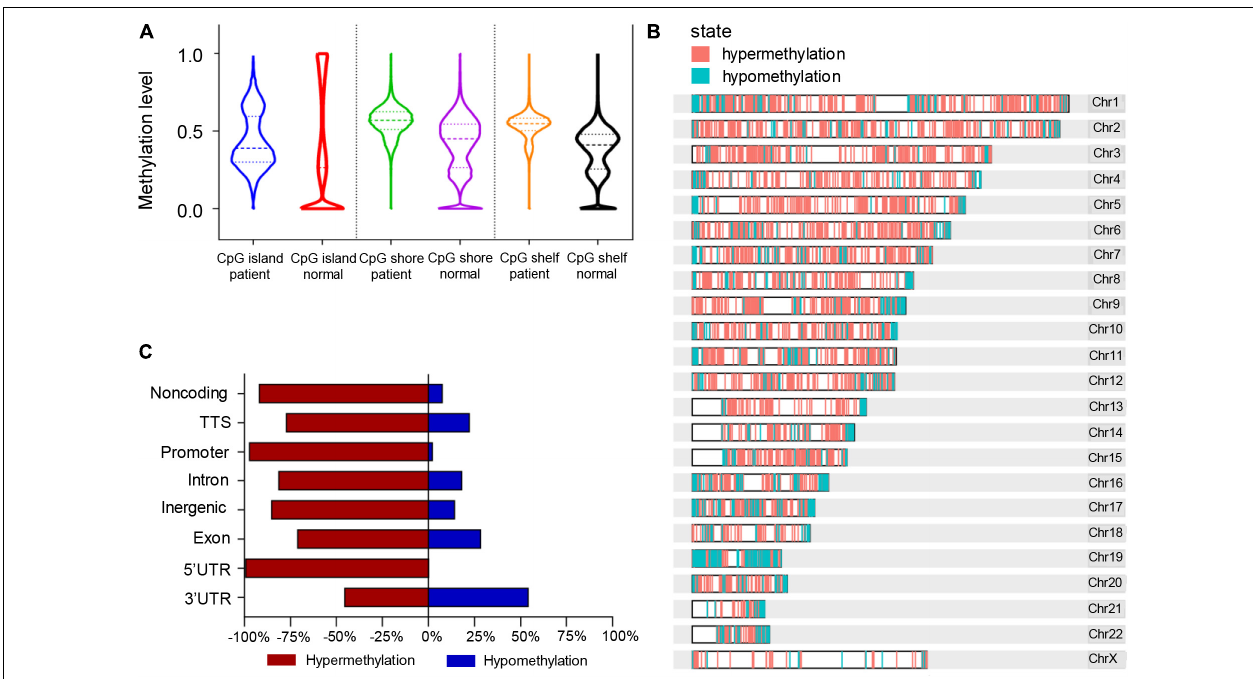
FIGURE 4 | Differentially methylated regions (DMRs) of the CpG regions in pancreatic cancer patients and healthy controls. (A) Violin plots of DMRs located in CpG islands, CpG shores, and CpG shelfs of PDAC patients compared to controls. (B) Whole genomic and chromosomal location of DMRs in CGIs. (C) The different features of CGI distribution according to hypermethylated and hypomethylated